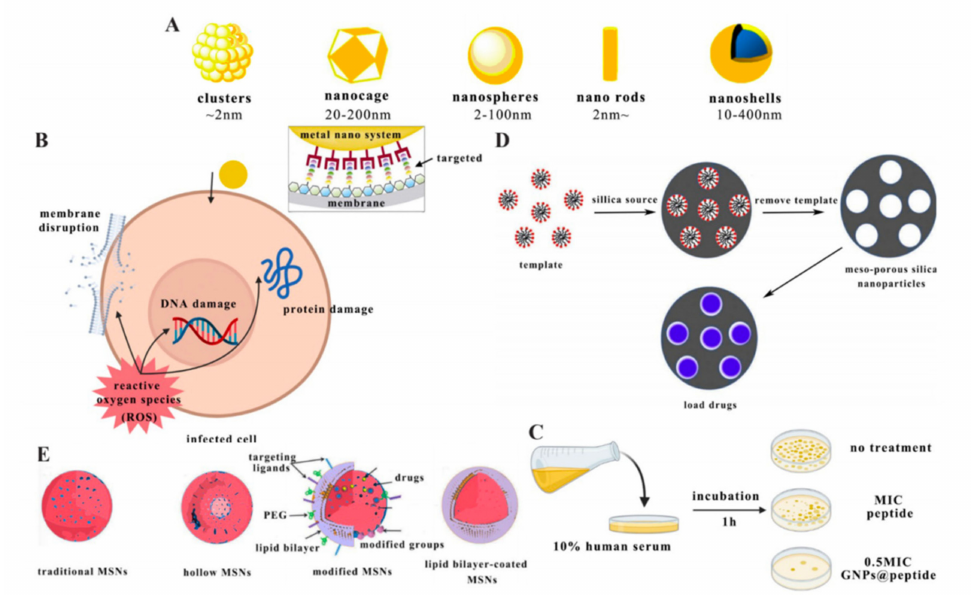
Figure 8. ( A ) Shapes of metal nanocrystalline materials adapted from [155]. ( B ) Antibacterial effect of IONP–peptide adapted from [170]. ( C ) Significant antibacterial effect of GNP–peptide in human serum [149]. ( D ) Schematic drug loading process of mesoporous silica nanoparticles adapted from [165]. ( E ) Schematic models of mesoporous silica nanoparticles adapted from